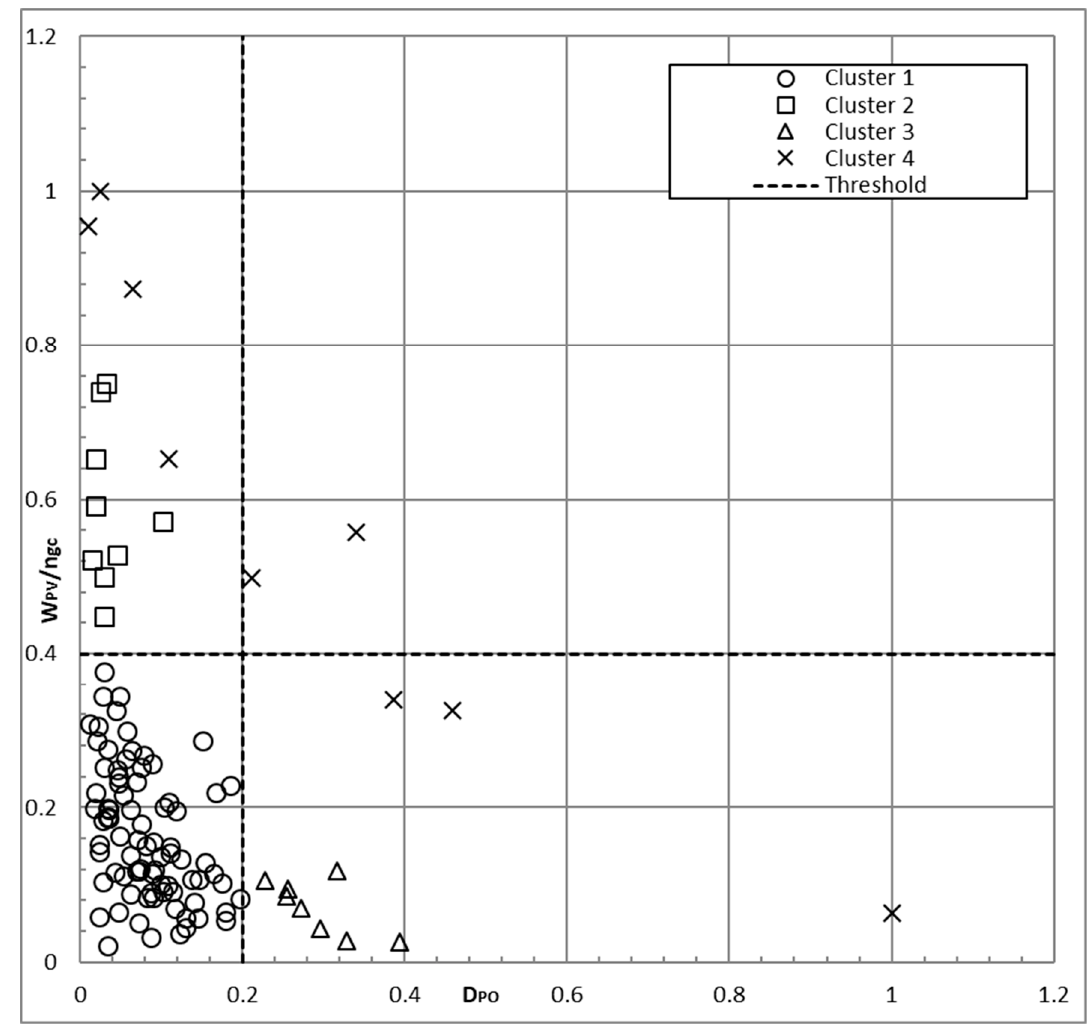
(cid:18) (cid:19) ) (cid:2898) and W PV and (cid:2924) (cid:3165)(cid:3161) n gc N